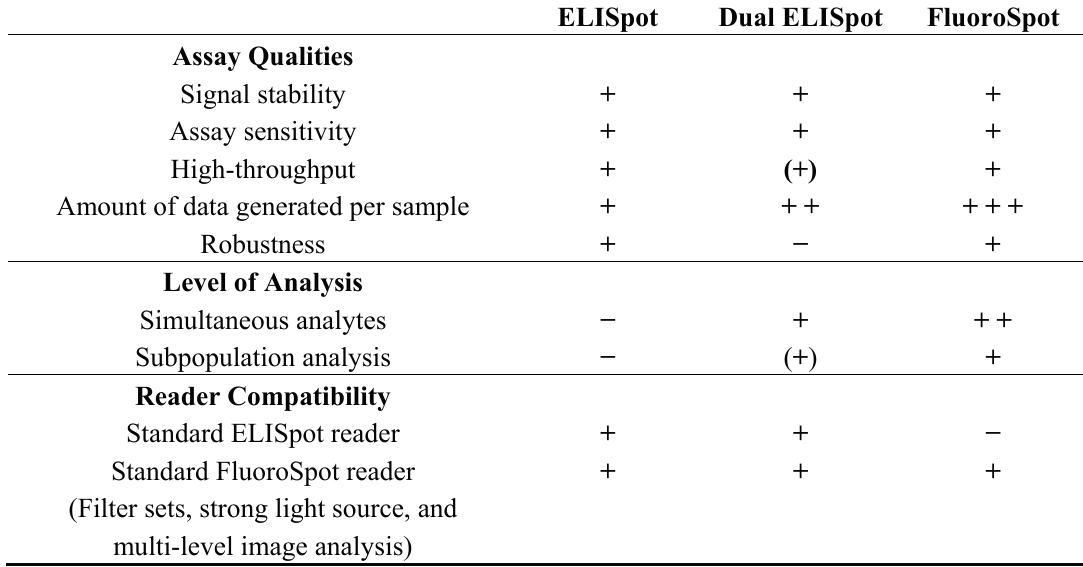
Table 1. Summary of the pros and cons for automated evaluation of different ELISpot assay